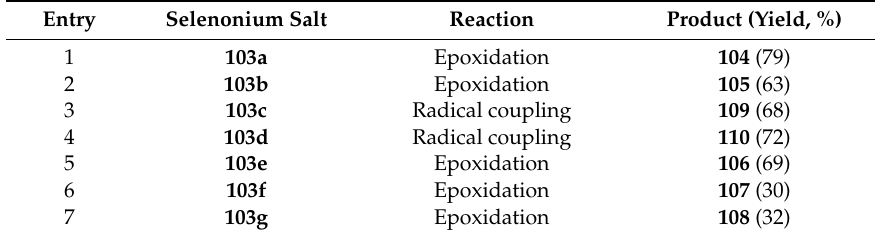
Table 8. Electrochemical reduction of selenonium salts 103a – g without benzaldehyde. Table 7. Electrochemical reduction of substituted methyltetrahydroselenonium bromide 103a – g in the presence of